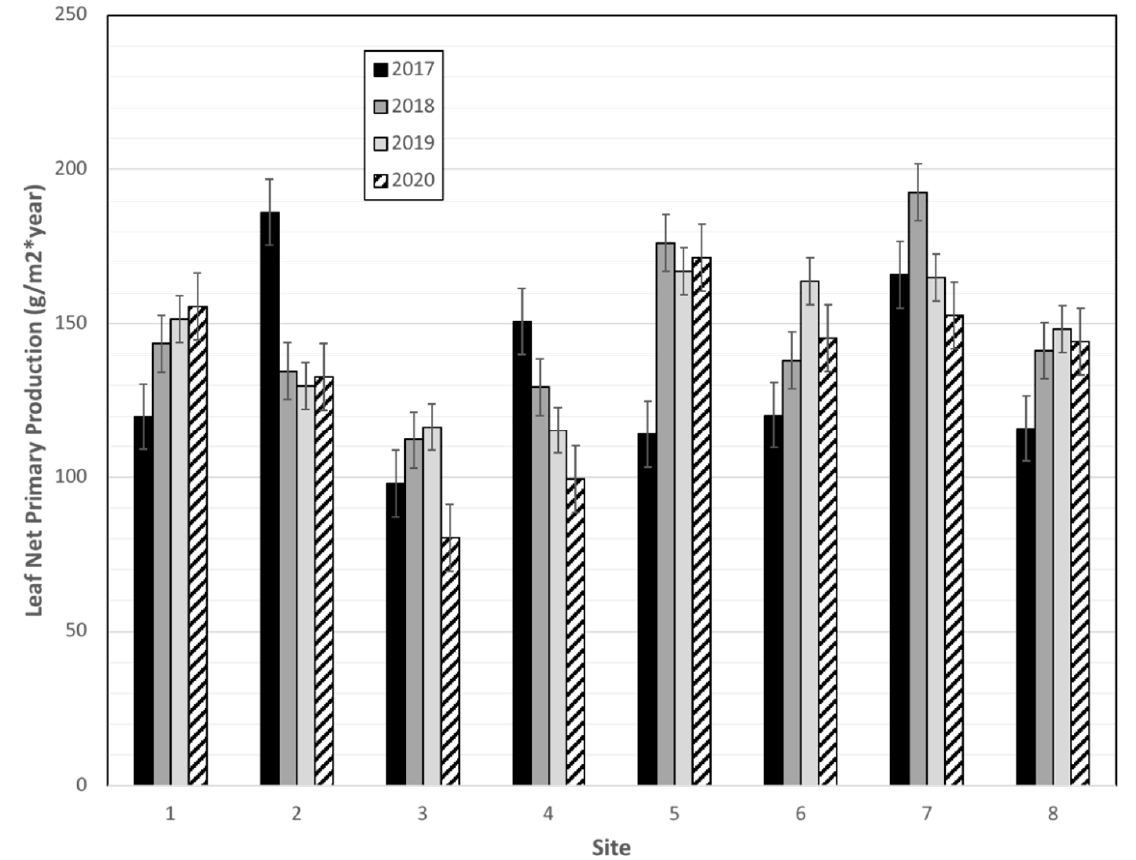
Figure 9. Leaf litter production (gm m -2 y -1 + s.e.) for each site in the Lac des Allemands swamp during 2017 (black), 2018 (dark gray), 2019 (light gray), and 2020 (striped) as well as the reference site (Site 1). Taxodium distichum produced far more leaf litter than Nyssa aquatica , and both produced far more litter than midstory species (F 2, 118 = 257.85, p < 0.0001; Figure